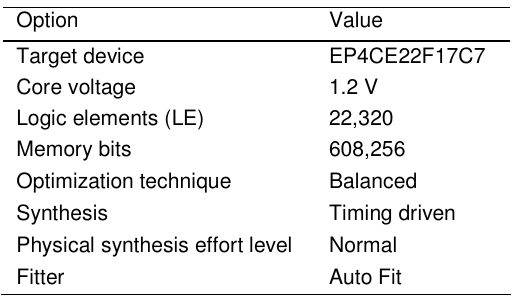
Table 3. Compilation options for Quartus-II tools.